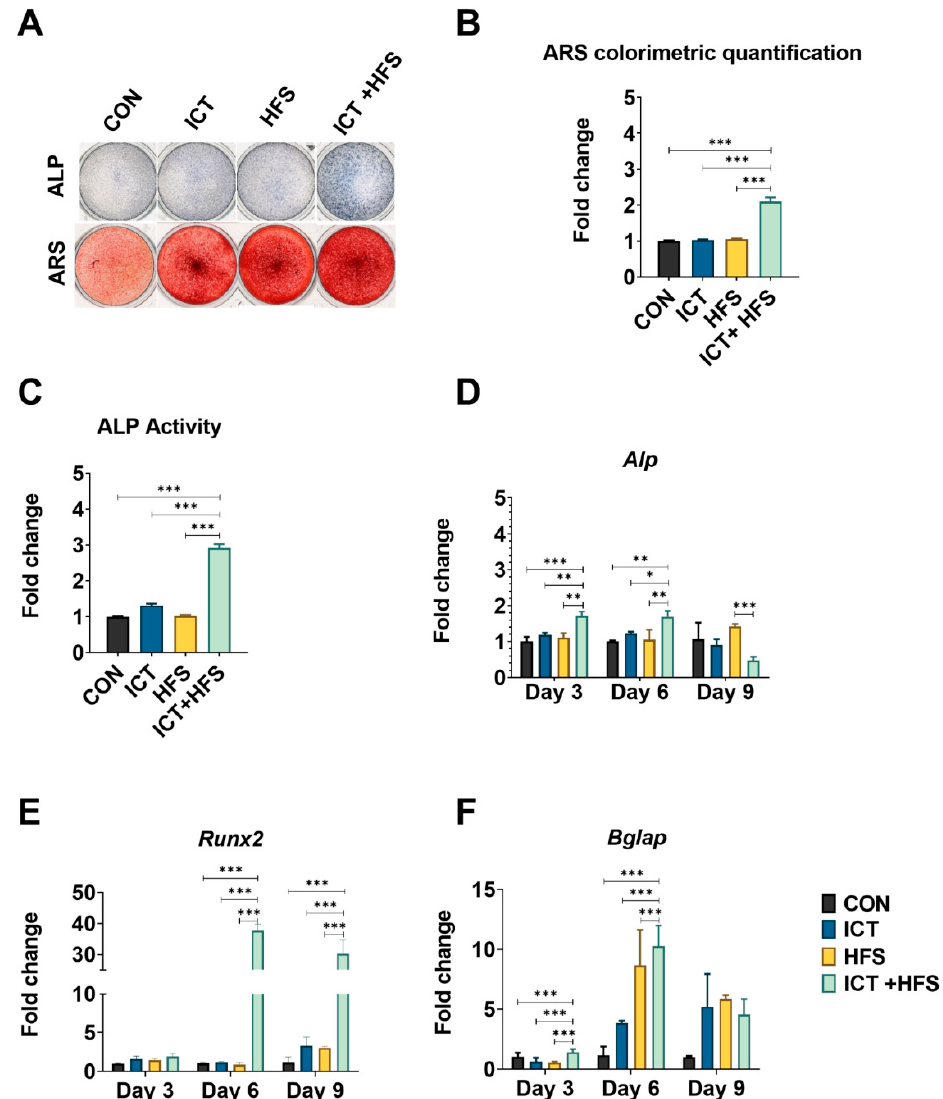
Figure 1. The additive effect of ICT and HFS on osteogenic differentiation of rMSCs. Cells were treated with ICT (1 µM), HFS (50 µg/mL), or their combination (ICT (1 µM) + HFS (50 µg/mL)). The cells treated with the vehicle served as controls (CON). ( A ) Top: ALP activity. Bottom: ARS staining. ( B , C ) Semi-quantitative analysis of ALP and ARS staining. ( D – F ) mRNA expression levels of osteogenic markers Alp , Runx2 , and Bglap . Data are shown as mean ± SD (* p < 0.05, ** p < 0.01, *** p < 0.001, one-way ANOVA with Tukey’s HSD, n = 3).